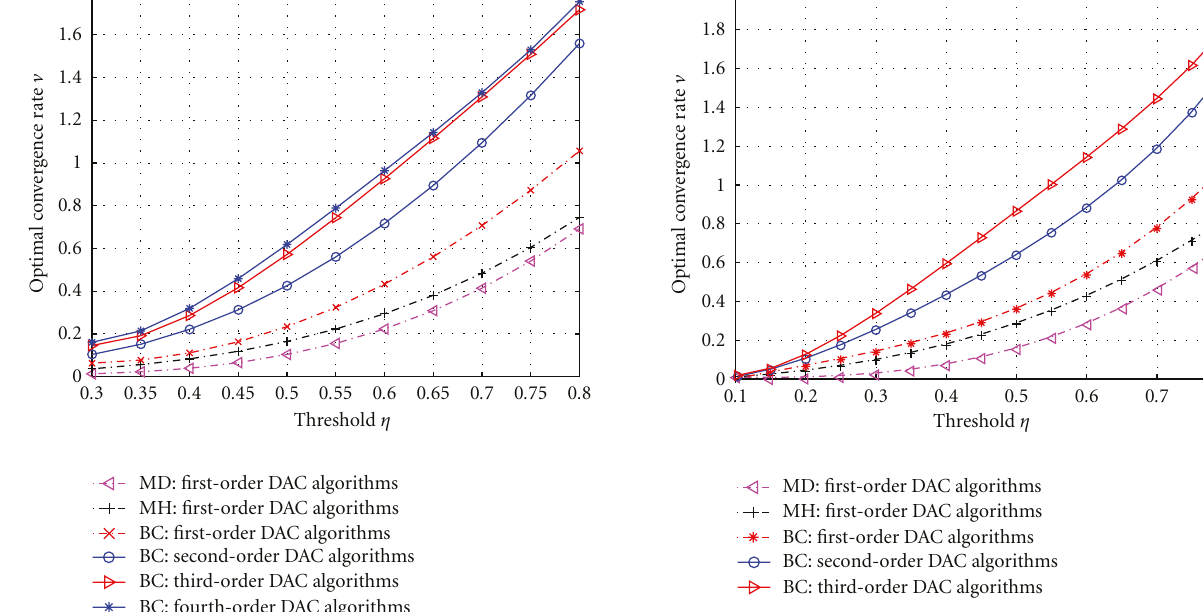
Figure 2: Convergence rate comparison of DAC algorithms with various weights in random networks versus distance threshold when N = 16.